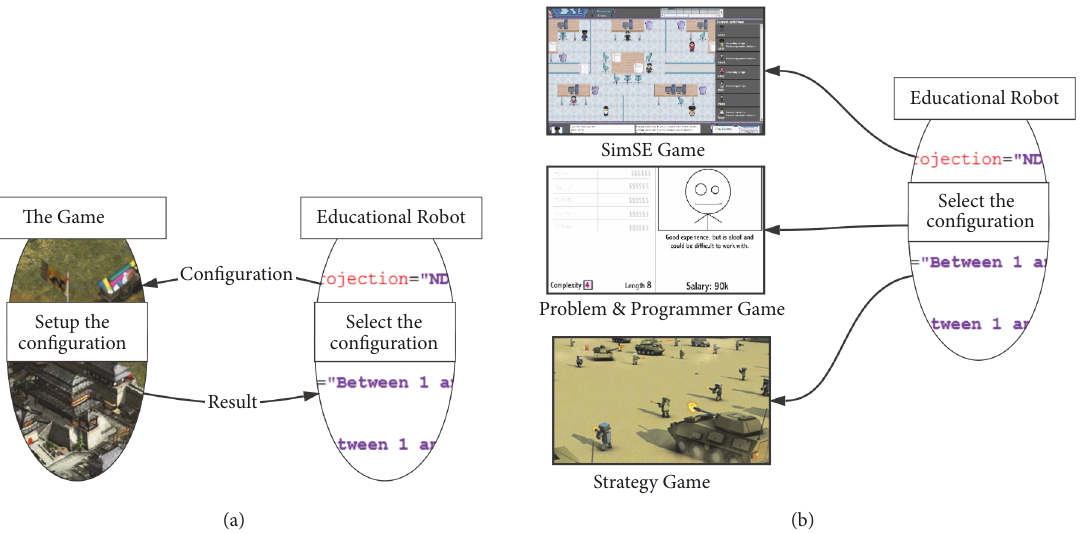
Figure 9: (a) Communication between the educational robot and the game. (b) Integration of the educational robot into different